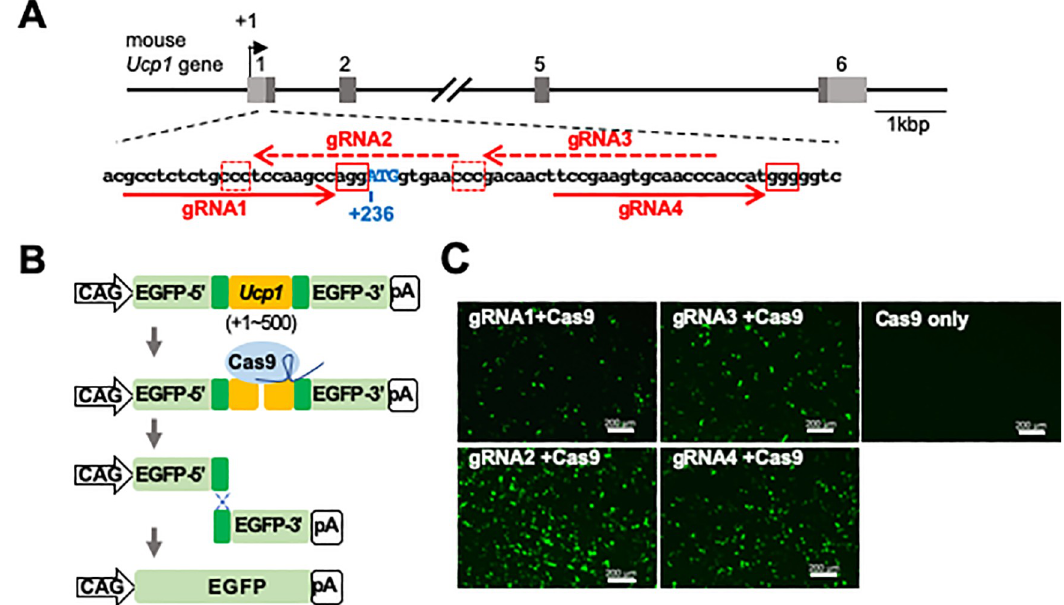
Fig 1. Selection of the optimum gRNA sequence to generate Ucp1-iRFP720 KI mice. (A) Structure of the mouse Ucp1 gene. The boxes and the numbers above each box indicate the exons of the mouse Ucp1 gene. Light and dark gray regions within the exons indicate untranslated and translated regions, respectively. The position of the transcription start site is indicated by +1. The DNA sequence around the translation start site of the mouse Ucp1 gene is shown. The red arrows indicate the target sequences of the gRNAs (dashed arrows indicate the complementary sequences). The red boxes show the protospacer adjacent motif (PAM) sequences. (B) The assay system for estimating the functional genome editing efficiency of gRNAs. The Ucp1 gene (+1 ~ +500) containing the gRNA target sites (shown in orange) was inserted into pCAG-EGxxFP vector. When recruited by the gRNA (shown in dark blue) to the target site, the Cas9 nuclease (shown in light blue) introduces a double strand break in the target DNA. Because of homologous recombination between the duplicated sequences (shown in dark green), the EGFP-coding gene is recovered. (C) Fluorescence image of HEK293T cells two days after transfection. The Cas9 nuclease was expressed together with one of the four gRNA candidates (gRNA1~gRNA4) or without gRNA (Cas9 only). Scale bar, 200 μ